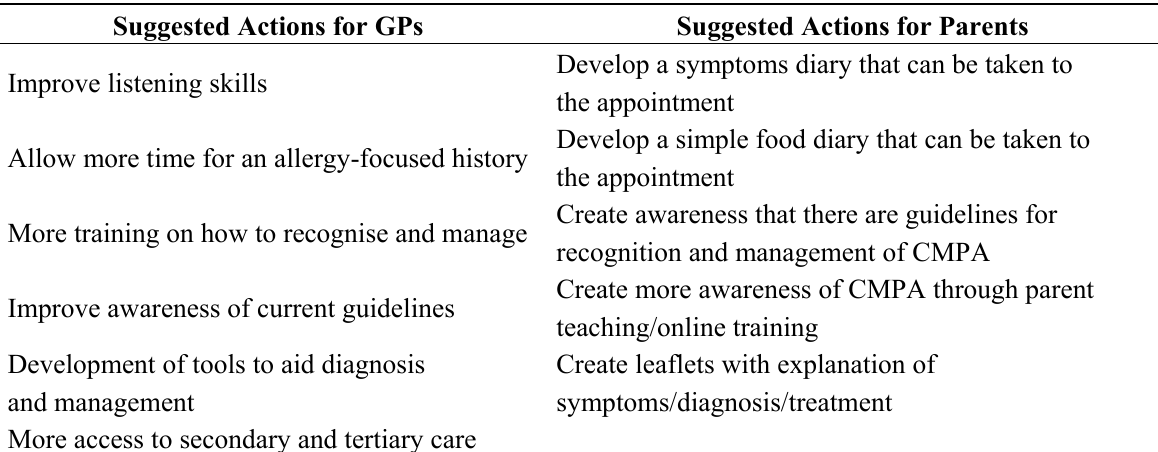
Table 3. Summary of suggestions from this survey to improve the diagnosis of